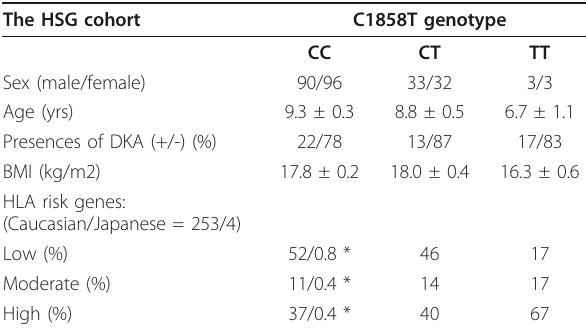
Table 1 Clinical characteristics at onset in type 1